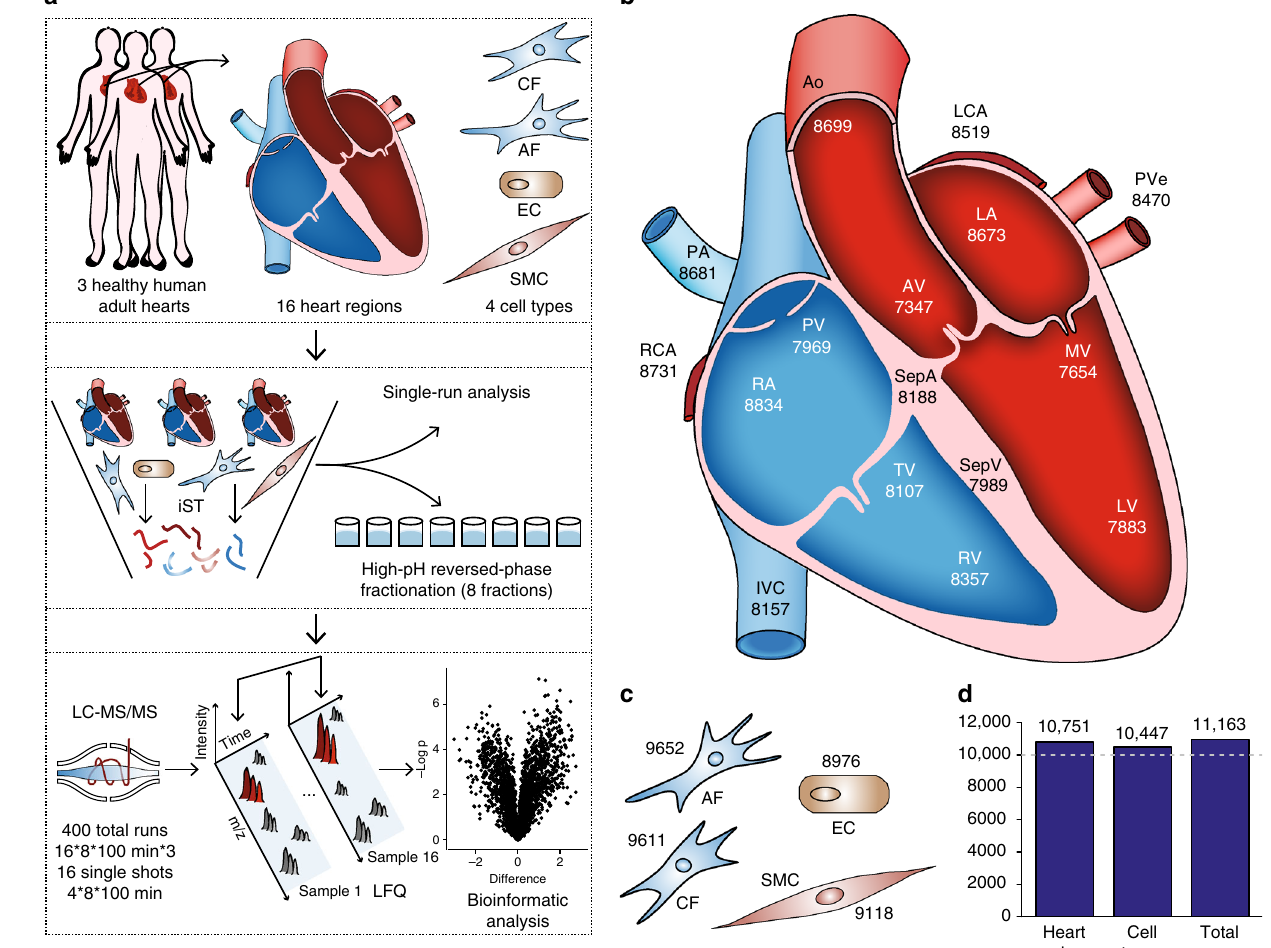
Fig. 1 The quantitative landscape of the human heart proteome. a Experimental design, including the source of material (upper panel), in-depth vs. single- run analyses (middle panel), and schematic depiction of the analytical work fl ow (lower panel). b Graphical illustration of the human heart showing the total number of quanti fi ed proteins in each region. c Quanti fi ed proteins in three cardiac cell types and adipose fi broblasts. d Bar plot of the total number of quanti fi ed proteins in all heart regions, cell types, and the entire data